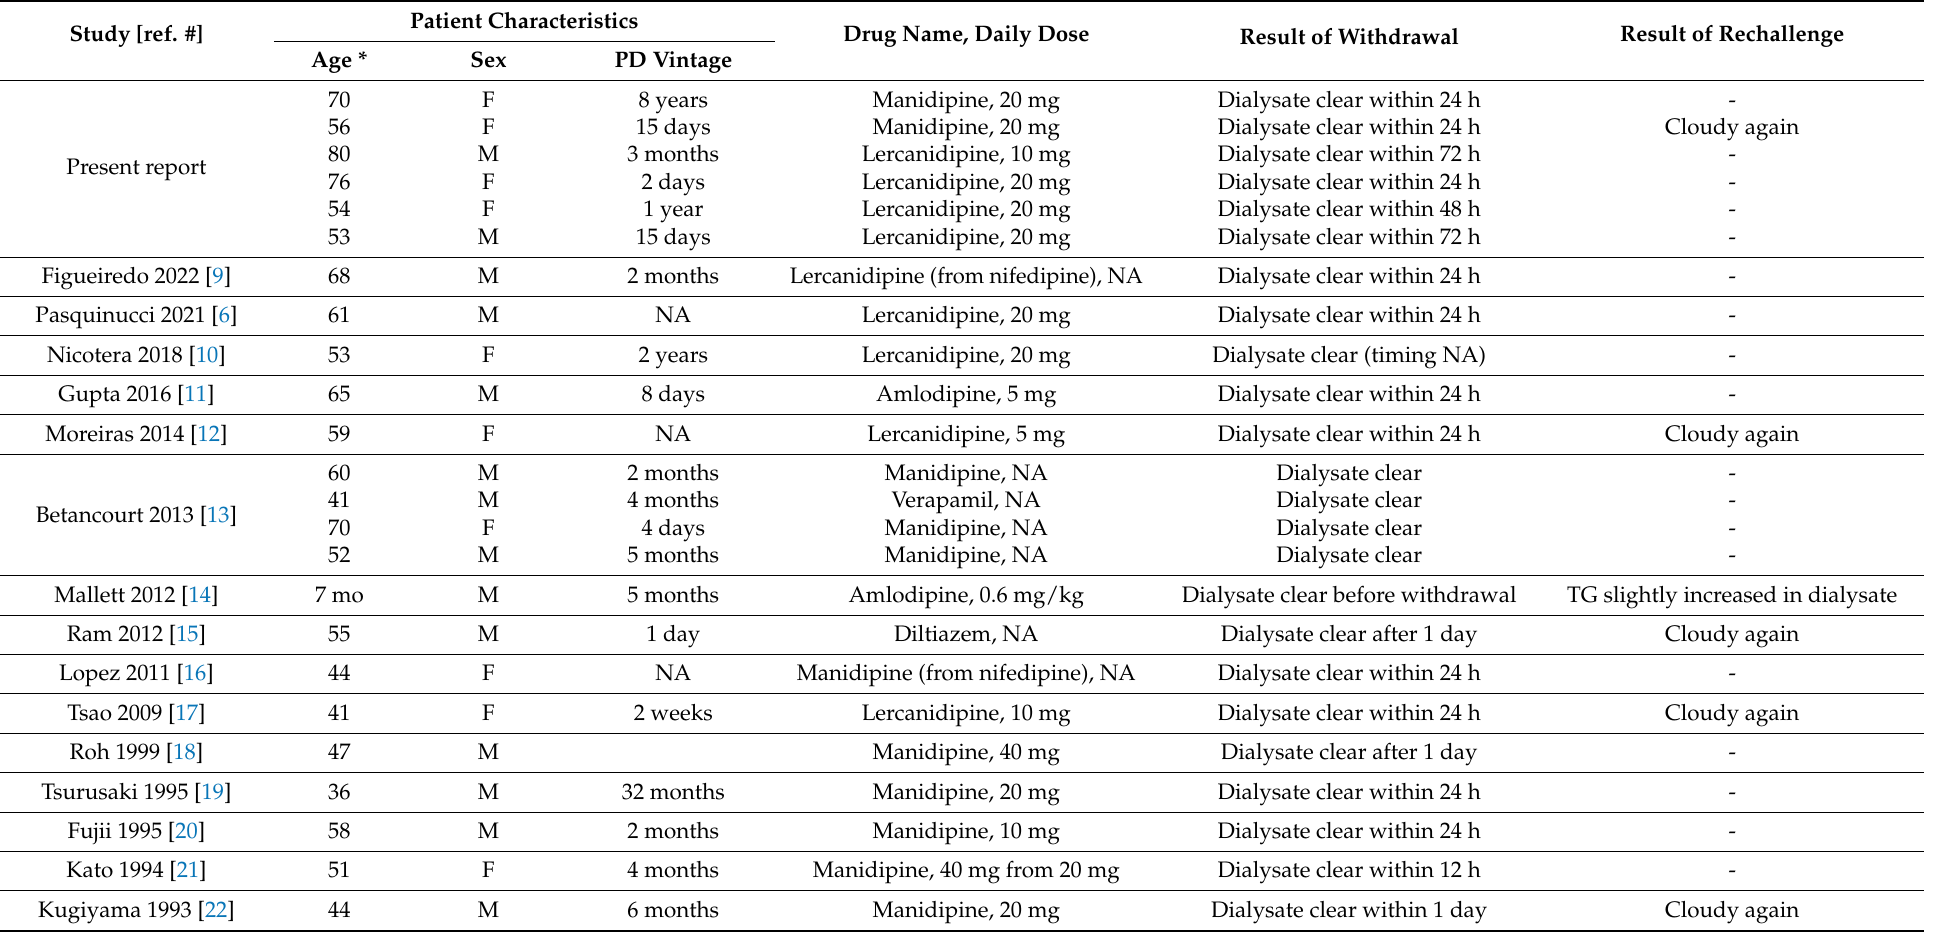
Table 2. Main characteristics of published case series and case reports of chyloperitoneum in PD patients. Study [ref.